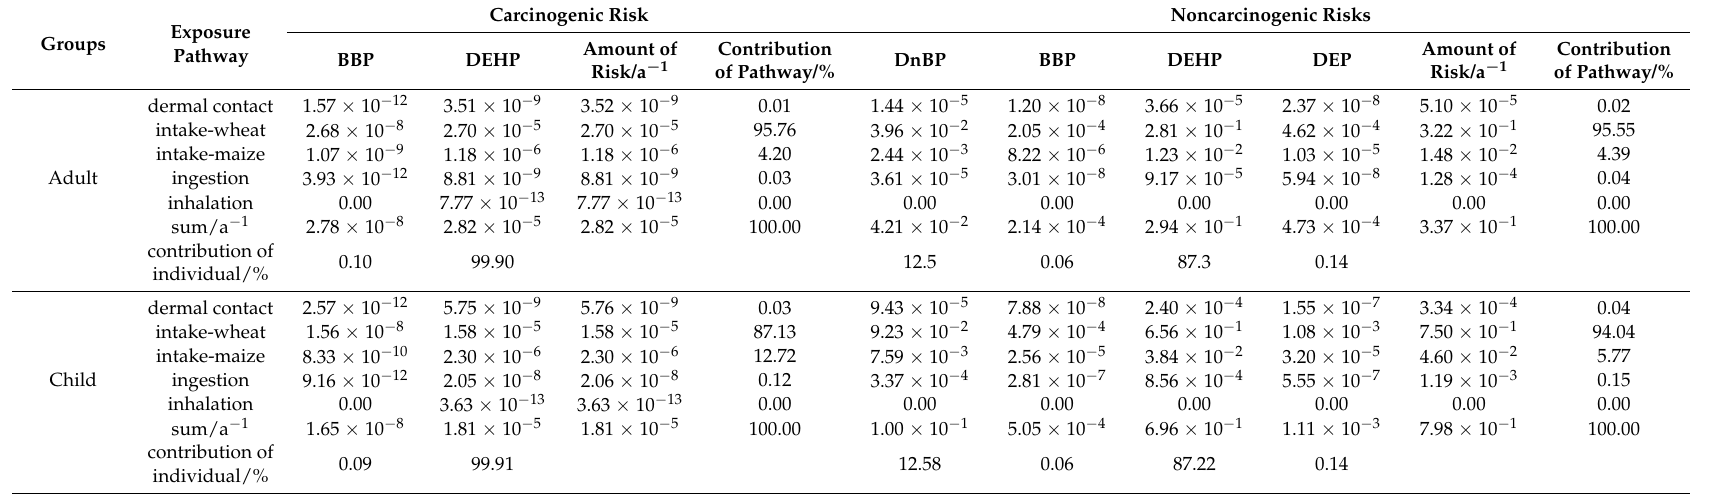
Table 8. Carcinogenic health risk and non-carcinogenic health hazard index of PAEs.